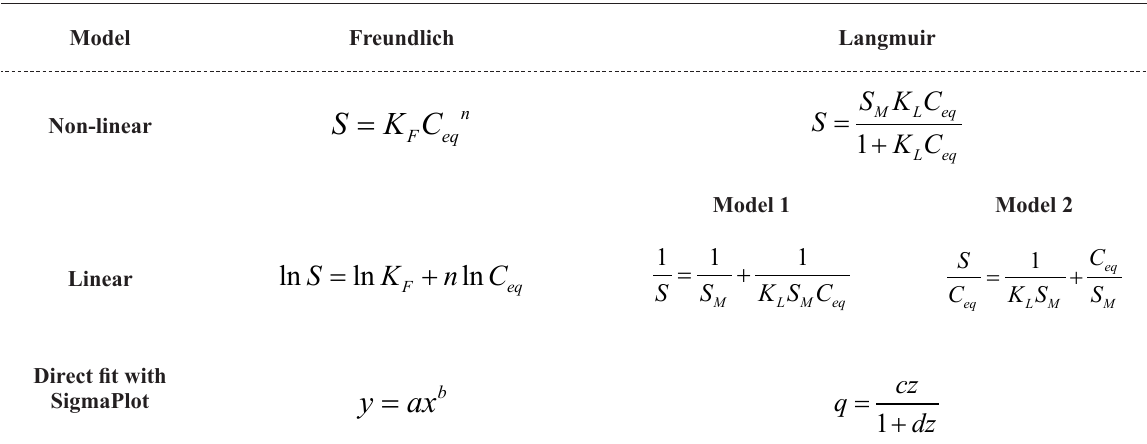
Linear and non-linear Freundlich and Langmuir isotherm models and equations used in the SigmaPlot for the direct fits of the